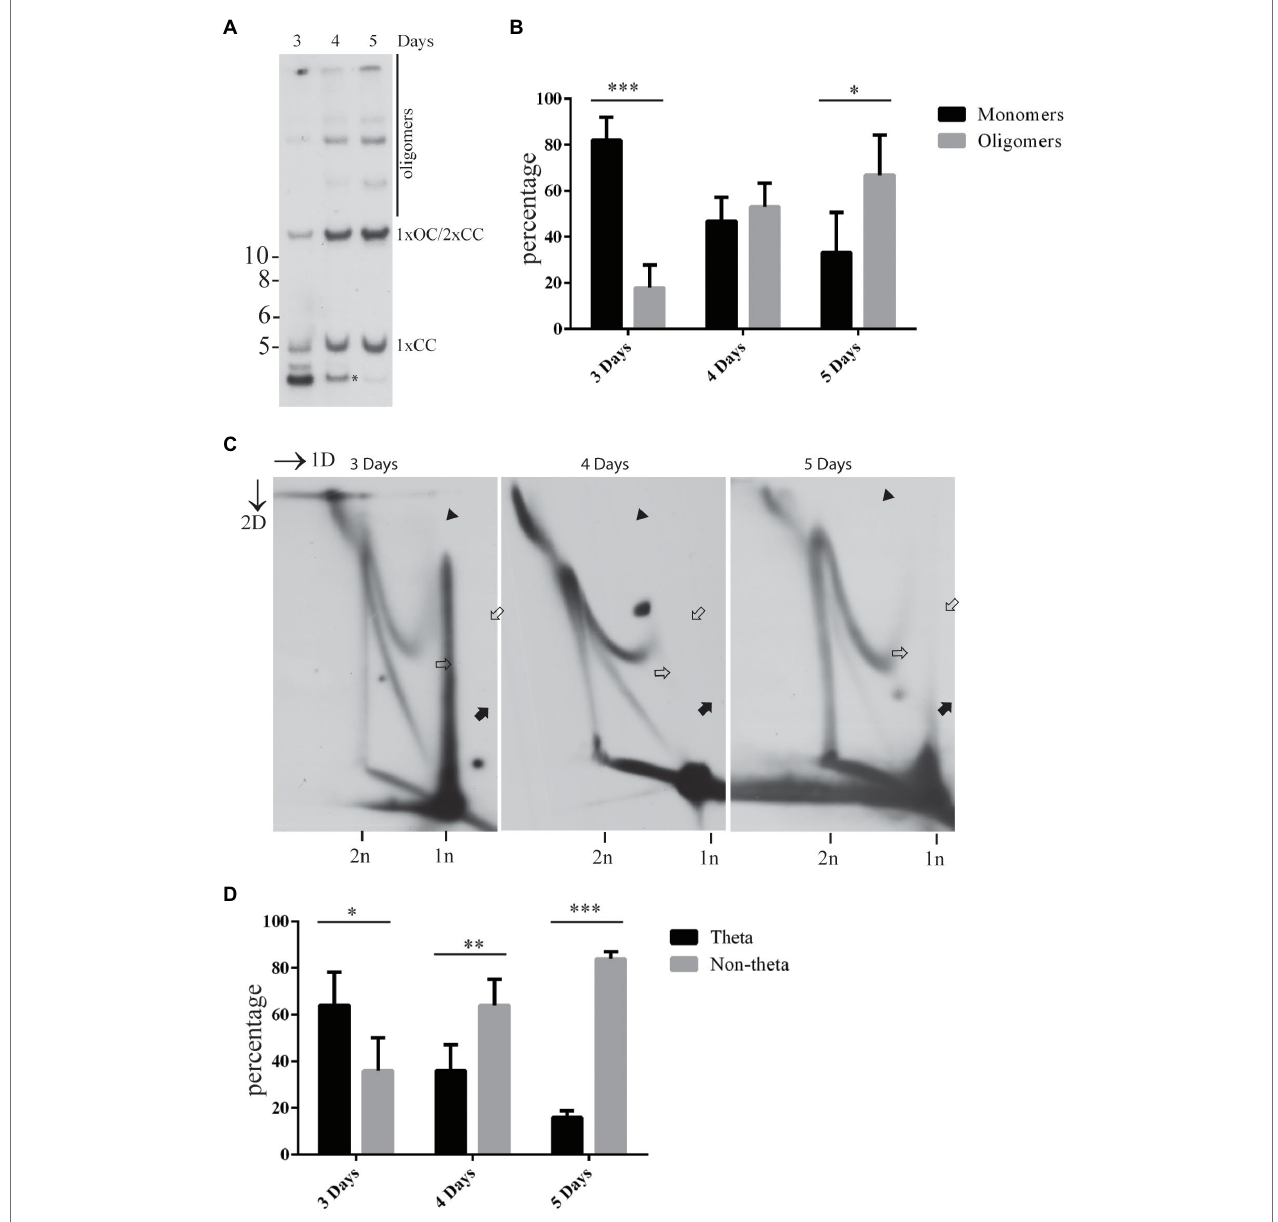
FIGURE 2 | Appearance of the non-theta replication intermediates during the transient replication of the HPV18 genomes in the U2OS cells concurs with the oligomerization of the replicated viral genomes. (A) An example of different forms of the HPV18 genome arising as a result of the transient replication in U2OS cells at 3, 4, or 5 days after the transfection. Genomic DNA was extracted from the cells at indicated time points, digested with HPV18 non-cutter HindIII and DpnI to separate non-replicated input DNA, resolved on 0.6% gel and analyzed by SB. Migration of the monomeric closed circular (1xCC), monomeric open circular (1XOC), dimeric closed circular (2xCC), and oligomeric forms are shown. Asterisk represents migration of non-replicated, DpnI sensitive fragment of HPV18. (B) Quantification of the replicated monomeric and oligomeric HPV18 genomes at 3, 4, and 5 days after the transfection in the U2OS cells. The data are expressed as average means ± the SD ( * p < 0.05; ** p < 0.01; and *** p < 0.001) of four independent experiments. Monomeric open circular and dimeric closed circular genomes migrate together under the conditions used to resolve DNA and were therefore omitted from calculation. (C) An example of different types of the replication intermediates arising during the transient replication of the HPV18 genome in U2OS cells at 3, 4, and 5 days post-transfection. Black arrows refer to the theta replication intermediates, black arrowheads refer to the almost fully replicated genomes, white arrows refer to the non-theta replication intermediates. (D) Quantification of the theta- and non-theta replication intermediates arising during the transient replication of the HPV18 genomes at 3, 4, and 5 days after the transfection in the U2OS cells. The data are expressed as average means ± the SD ( * p < 0.05; ** p < 0.01; and *** p < 0.001) of four independent